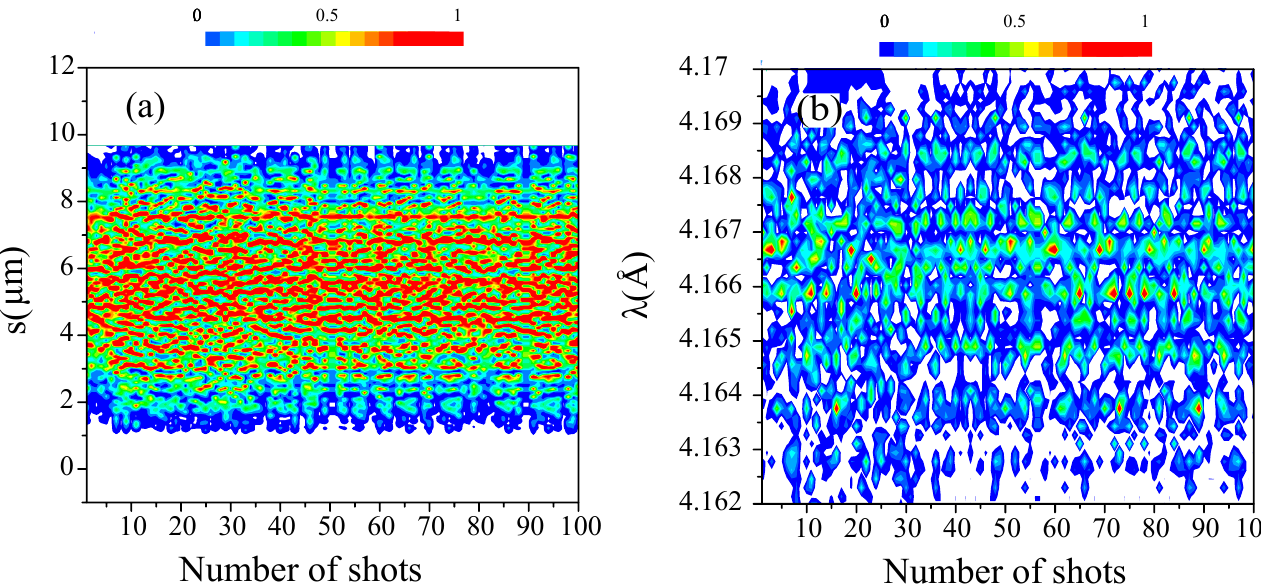
Figure 2. SASE ( a ) power vs. s = c τ and ( b ) spectrum vs. λ as a function of the number of shots. Logarithmic